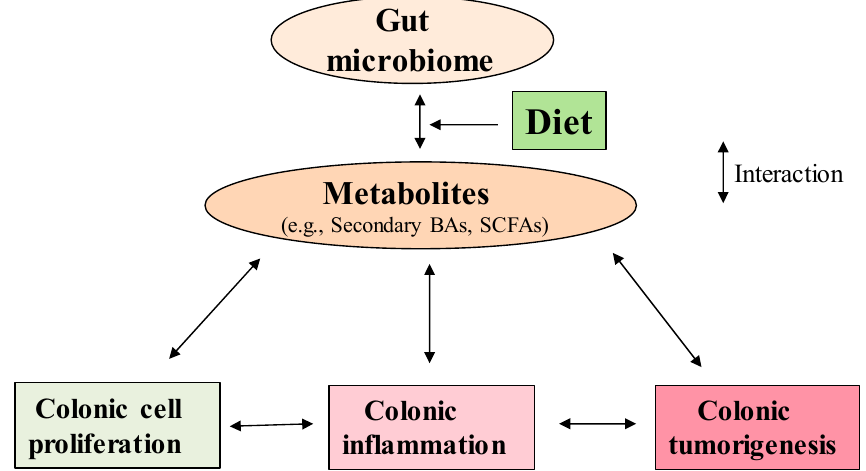
Figure 1. The interplay between gut microbiome, metabolites, colonic cell proliferation, inflammation, and cancer.